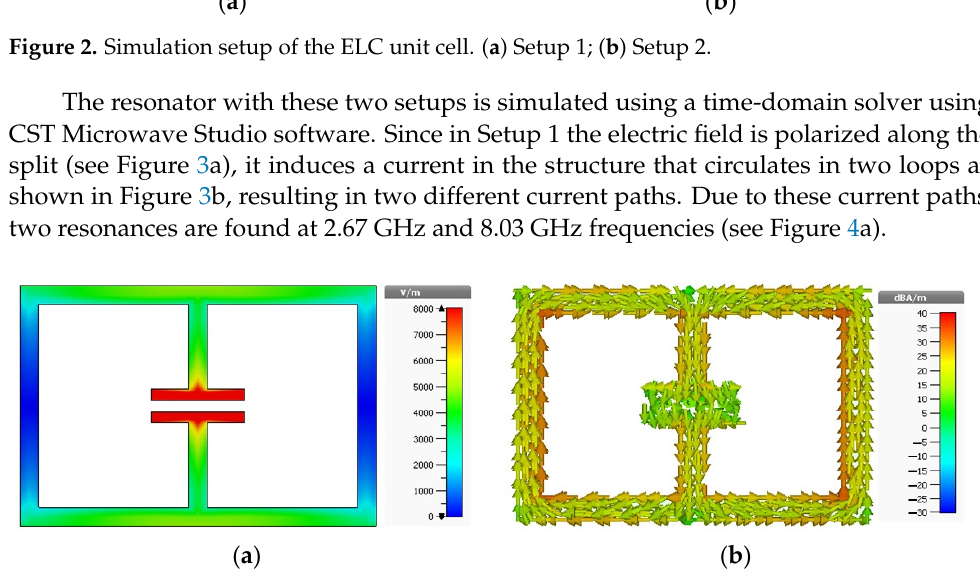
Figure 2. Simulation setup of the ELC unit cell. ( a ) Setup 1; ( b ) Setup 2.